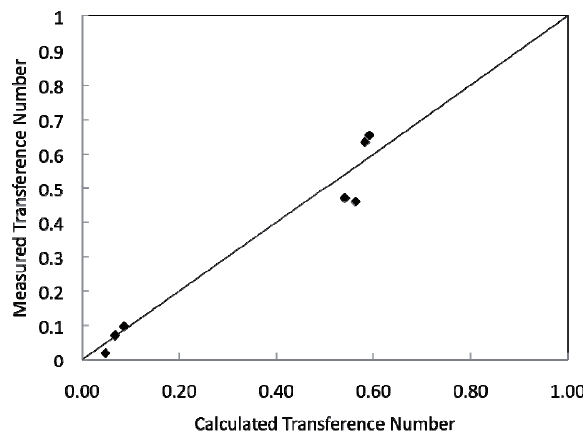
Figure 7. Model calculations plotted against measured re- sults.